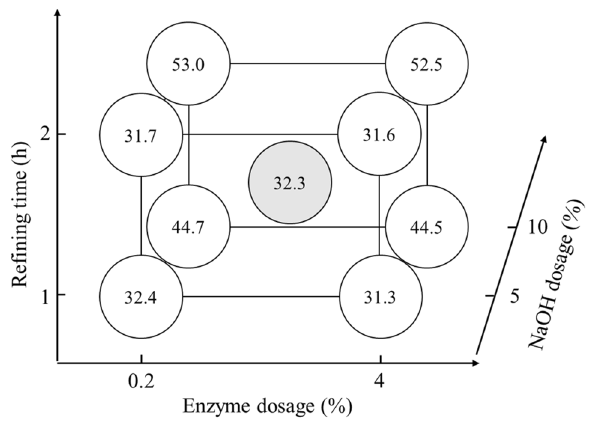
Figure 6. Factorial analysis of rice straw semi-chemical mechanical pulp with respect to acceptable fiber rates.